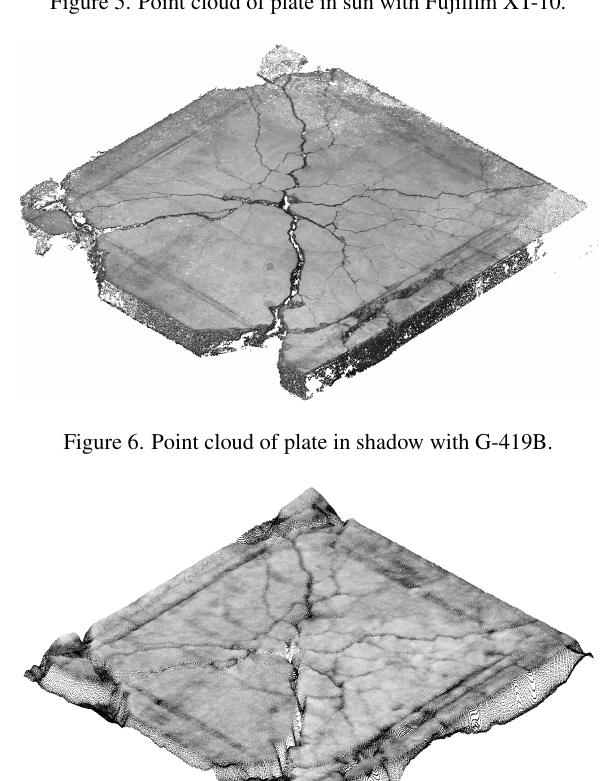
Figure 5. Point cloud of plate in sun with Fujifilm XT-10.